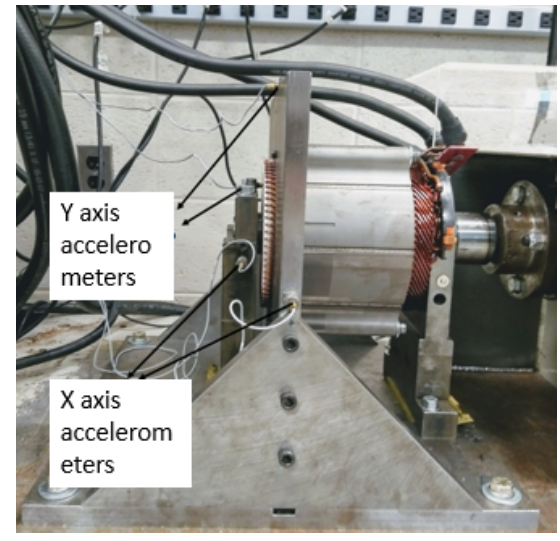
Figure 7. Placement of accelerometers on stator and rotor bearing housing.